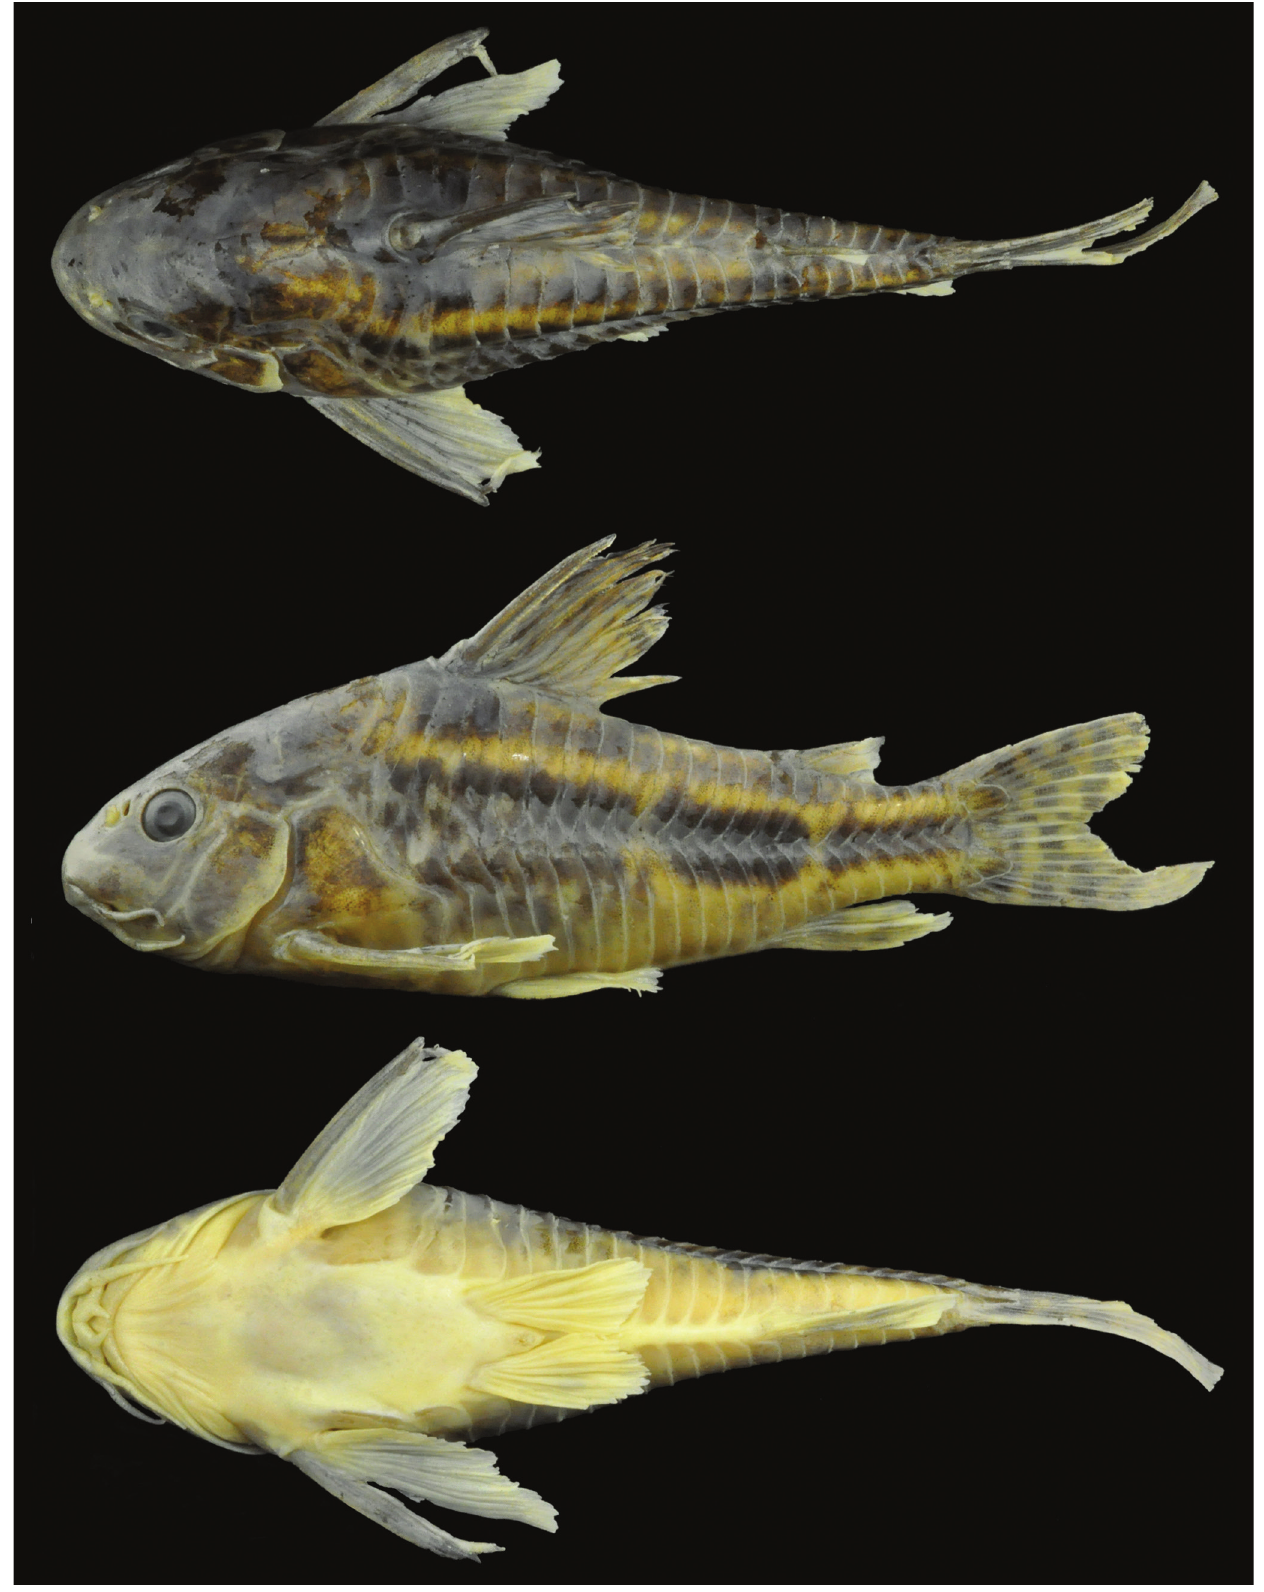
Fig. 2. Specimen of Corydoras paleatus , NRM 54230, 1, 53.5 mm SL, captured in córrego Sarandí, Canelones, Uruguay, near to the most plausible type-locality of C. paleatus , the Laguna del Diario, in Maldonado. Dorsal, lateral and ventral views. Photo by Celso